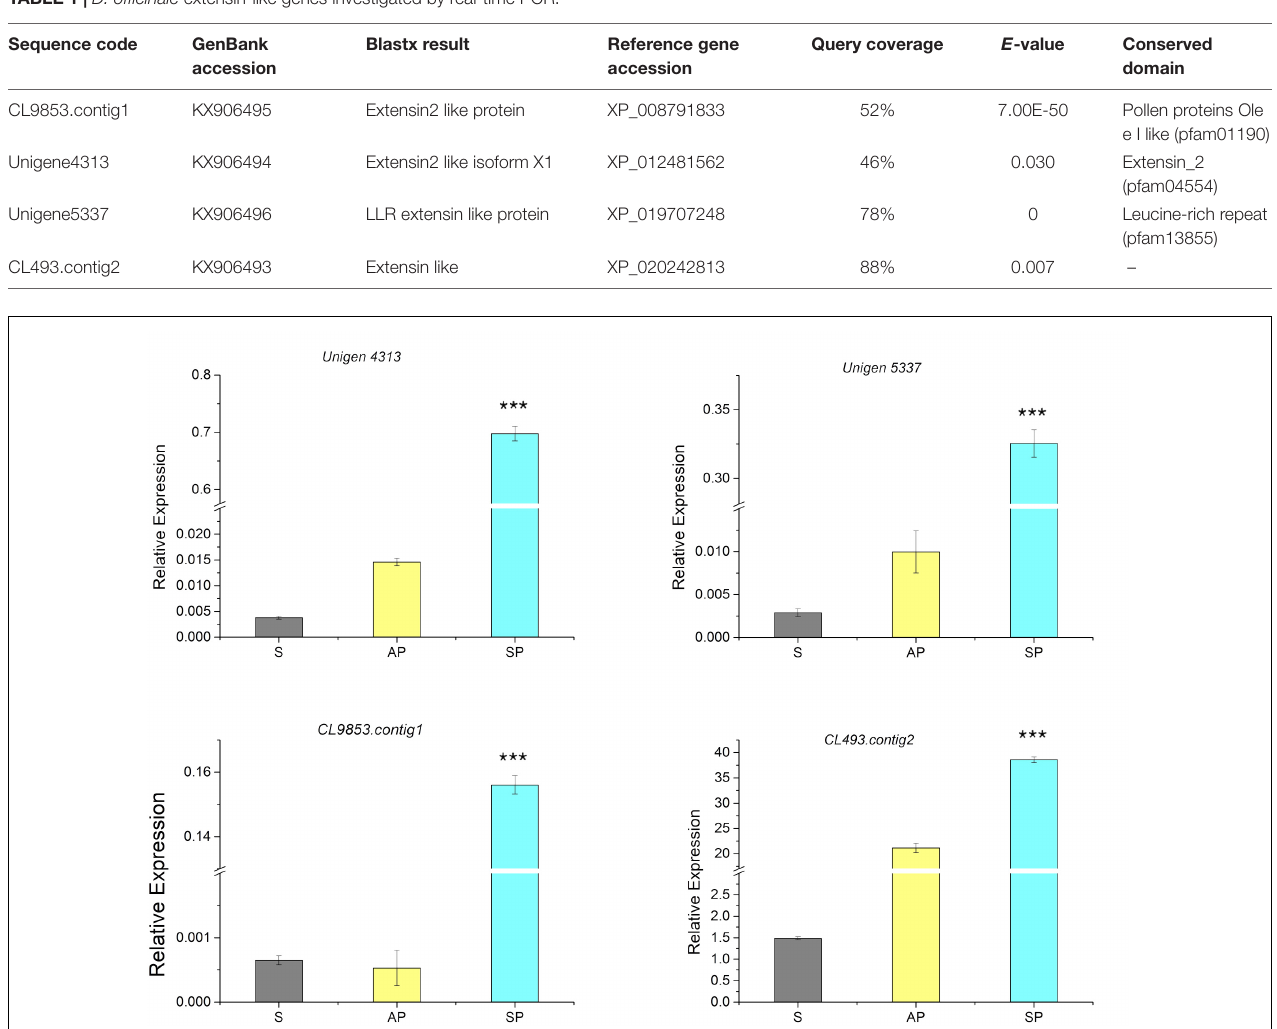
FIGURE 4 | Expression of genes coding for extensin-like genes in the mature seeds (S), symbiotically (SP), and asymbiotically (AP) germinated protocorms measured by real-time PCR. ∗∗∗ Indicates significant difference at P < 0.001 probability.